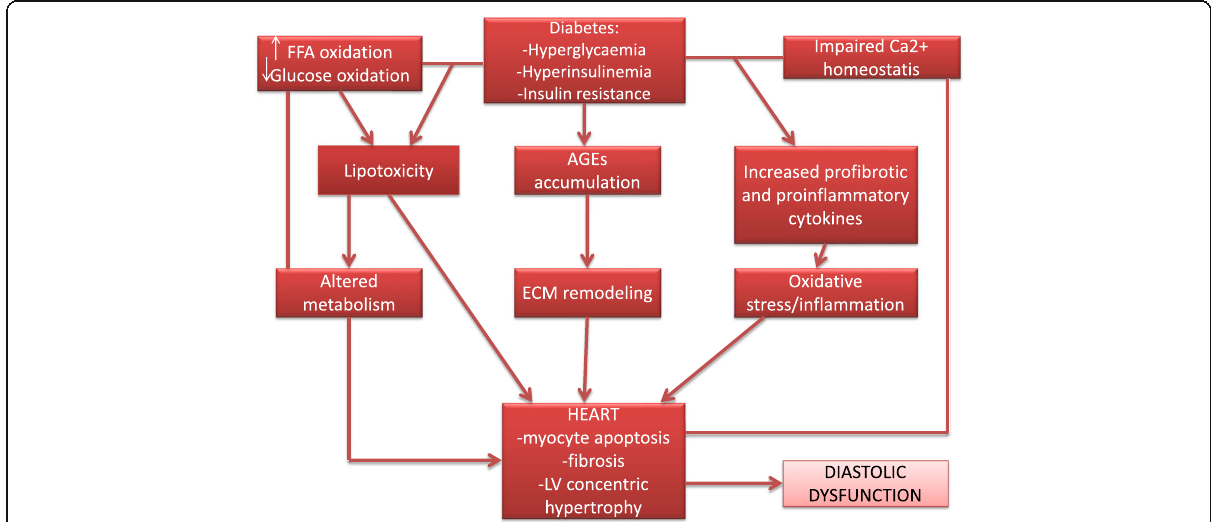
Fig. 4 Mechanism of the pathophysiology of cardiomyopathy of